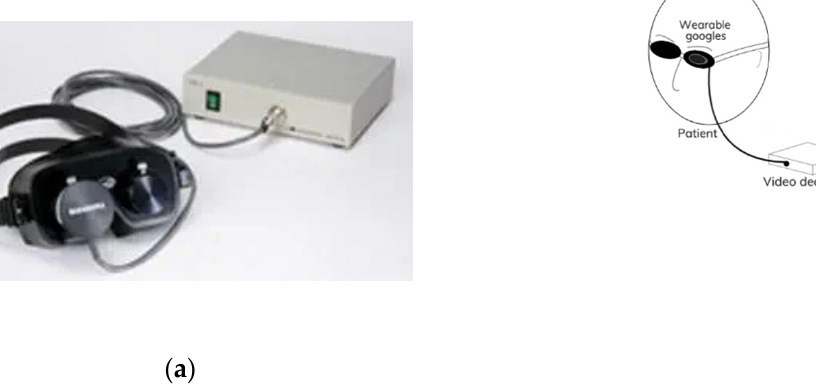
Figure 1. Eye movement observation equipment: ( a ) Infrared Eye Movement Imaging TV Device IEM-2 and video capture; and ( b ) system illustration.